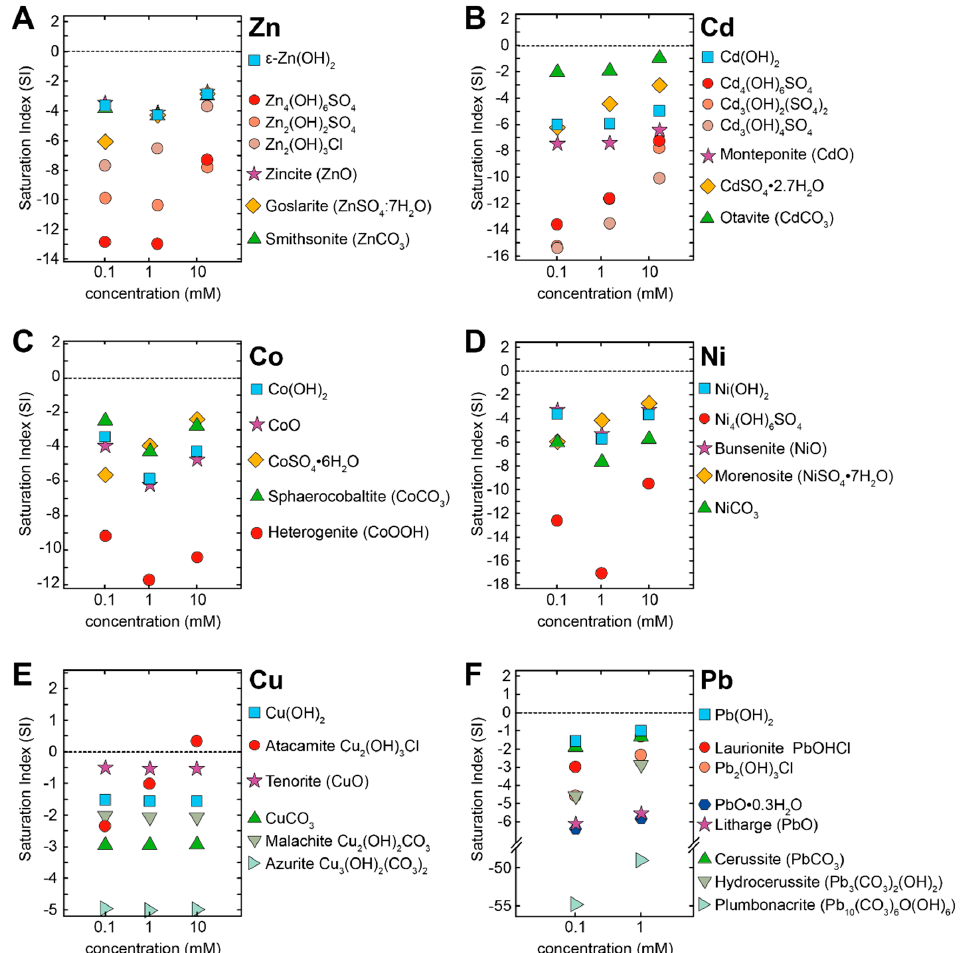
Figure 6. Bulk solution saturation indices of the relevant metal phases calculated using PHREEQC, with the minteq.v4 database. The calculations are based on the initial metal concentrations and bulk solution pH measurements (Table 2) made after the reaction of a ca. 3 mm × 3 mm × 0.2 mm large brucite crystal with 7 mL of 0.1–10 mmol/L metal solutions. All of the solutions had an initial pH of 4.5. The saturation indices of the carbonate phases were calculated under the assumption of